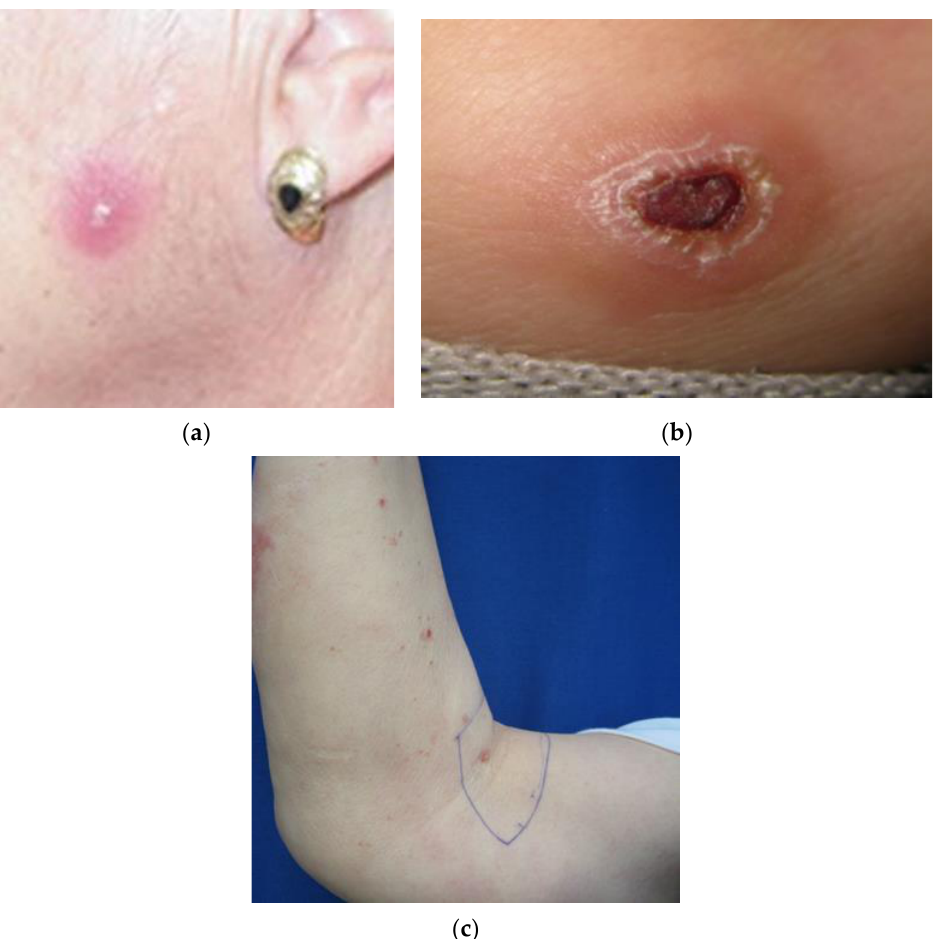
Figure 1. Cutaneous leishmaniasis lesion type: ( a ) single papule; ( b ) plaque with crust; ( c ) multiple lesion